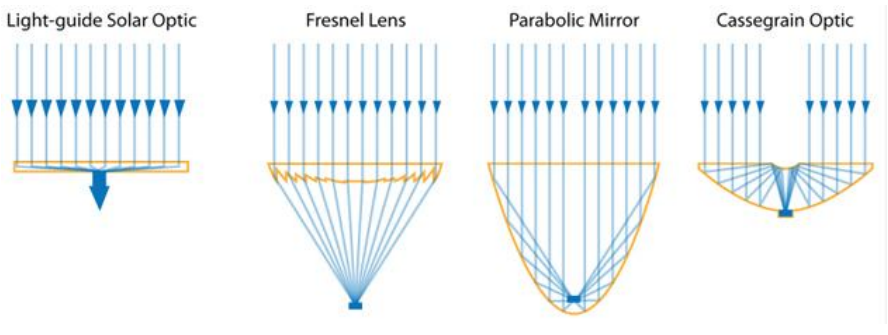
Figure 33. Optical structures for CPV systems [74].